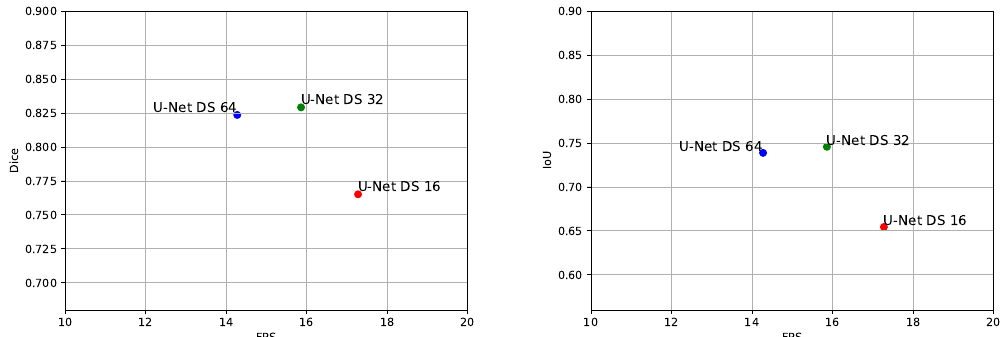
Figure 14. Comparison of the U-Net DS changing values of C to 16, 32 and 64 in Dice and IoU scores vs. FPS.